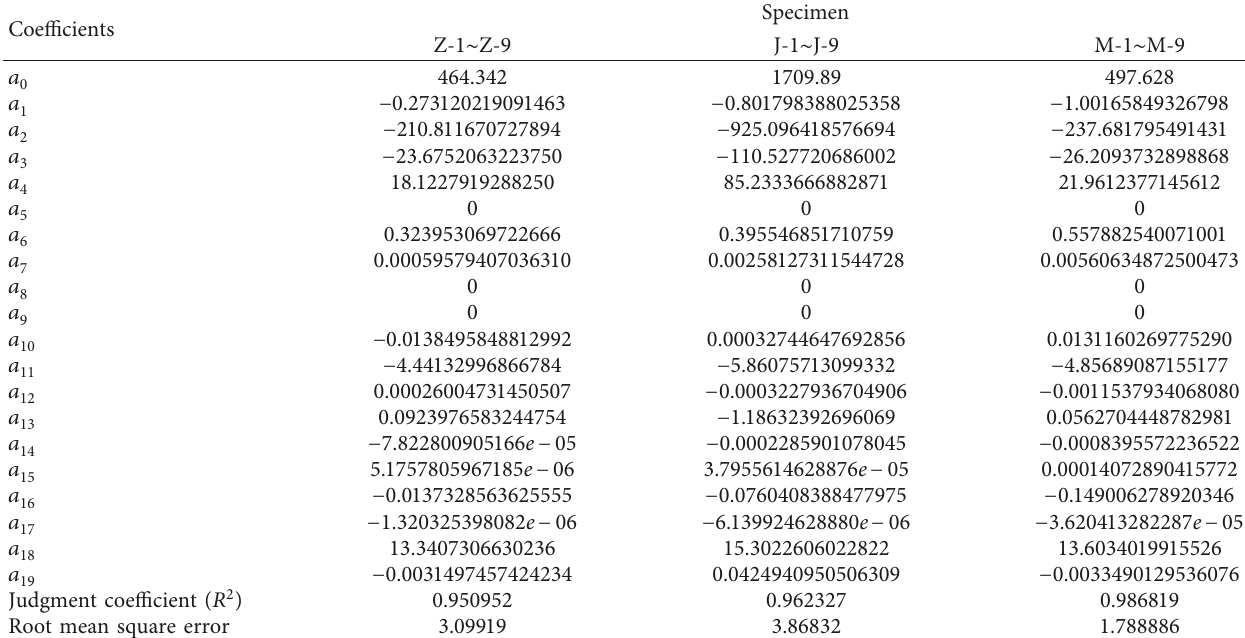
Table 10: Coefficients of cubic polynomial model Equation